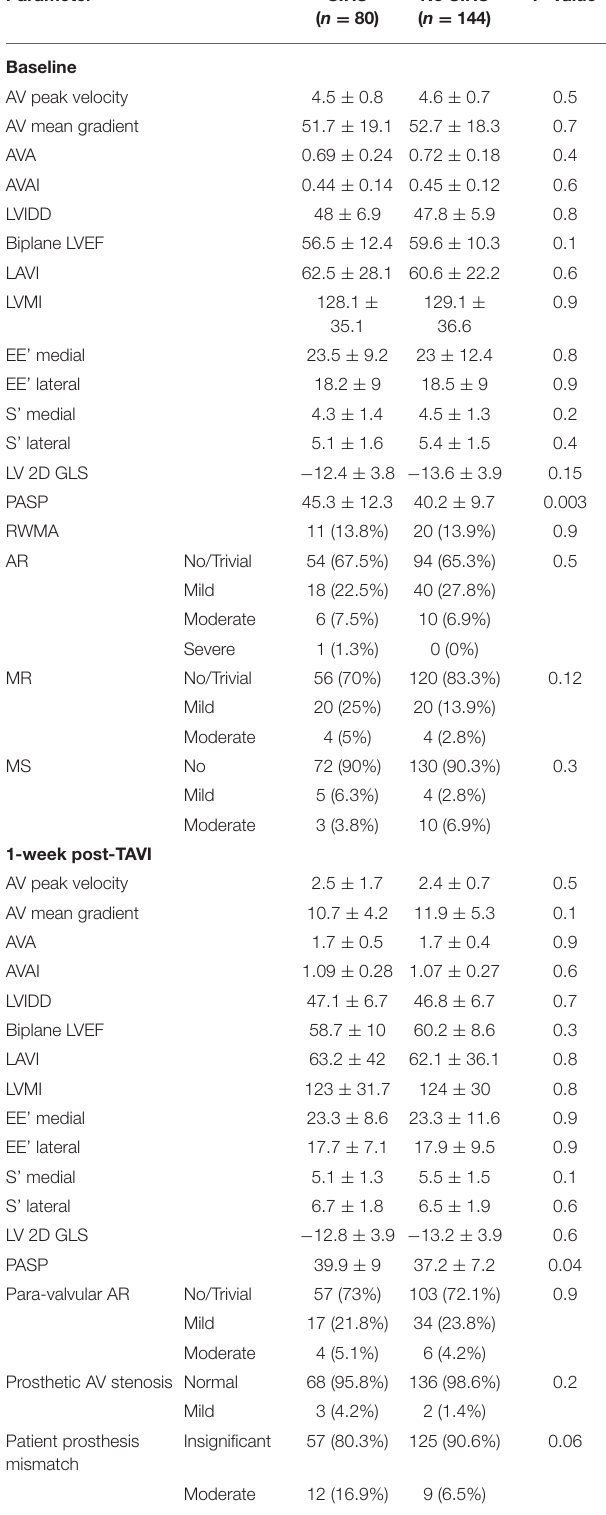
TABLE 5 | Baseline and Follow-up echocardiographic findings.